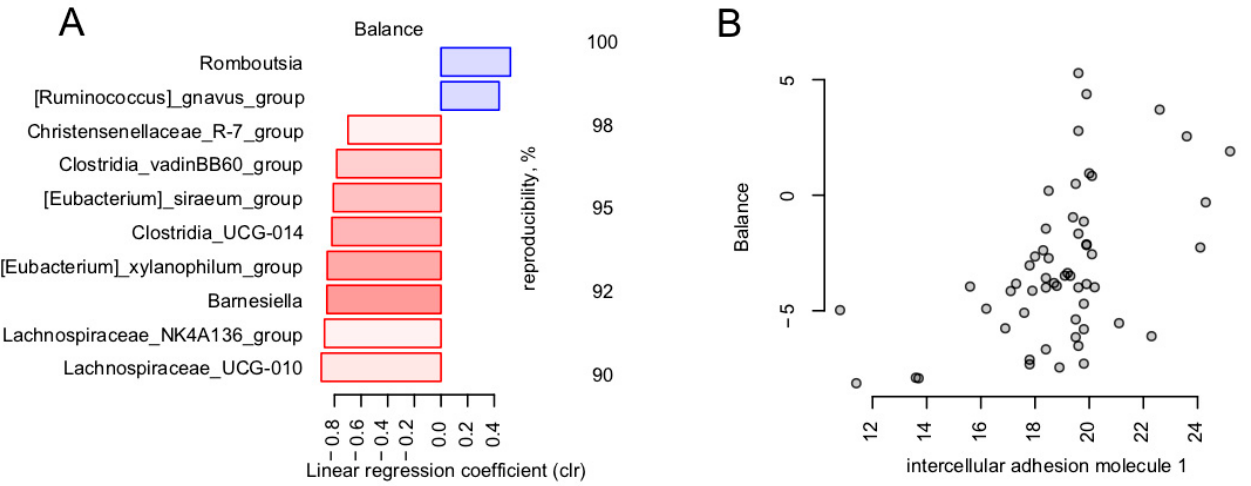
Figure 4. Link between endothelial dysfunction markers and gut microbiome in post-COVID-19. Reproducible taxa were revealed by nearest balance cross-validation associated with ICAM-1 (ng/mL). Constructed similarly to Figure 2: ( A ) Reproducible members of the nearest balances. ( B ) Relation between the balance composed of reproducible taxa and ICAM-1 ( n = 56).